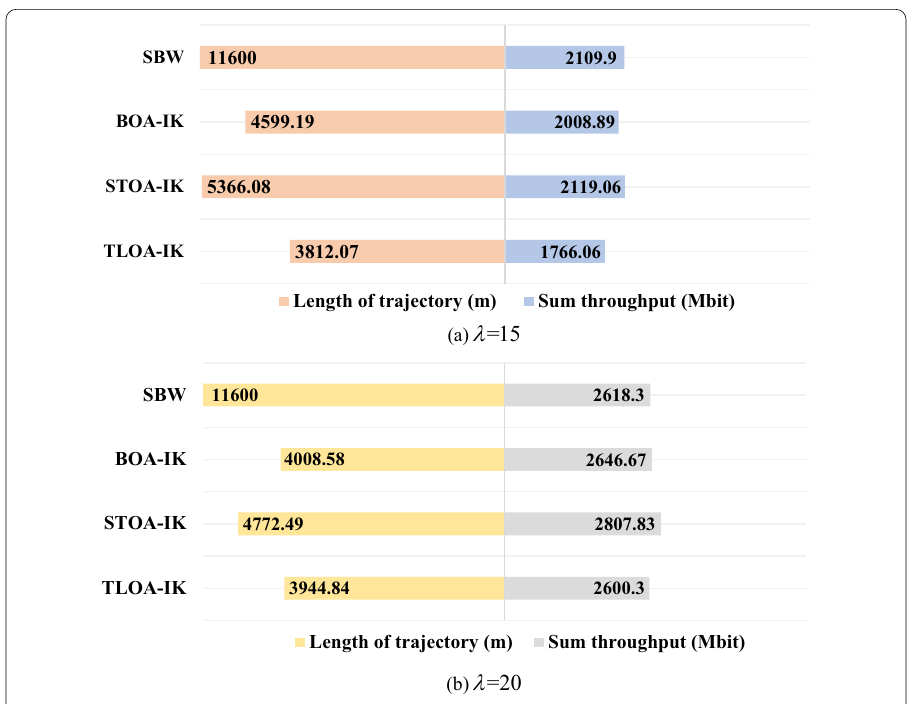
Fig. 9 Joint evaluation index performance of each algorithm under different DU